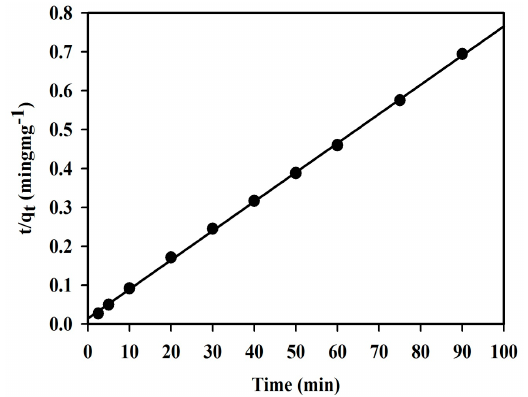
Figure 7. Pseudo second-order adsorption kinetic model of Zr(IV) uptake on 20 mg SG-APTMS-N,N-EPANTf 2 at pH 4.0 and 25 °C.